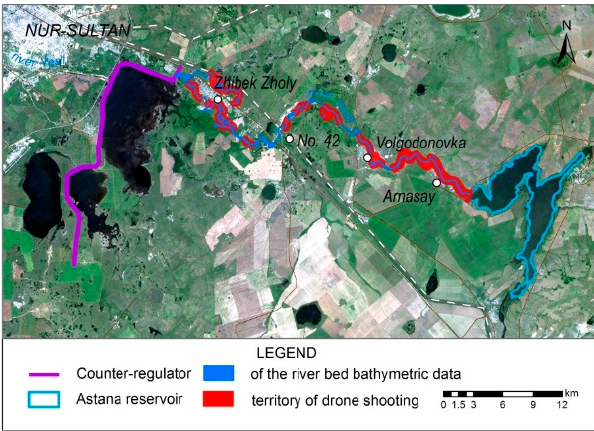
Figure 2. Territories with improved resolution of the DEM.